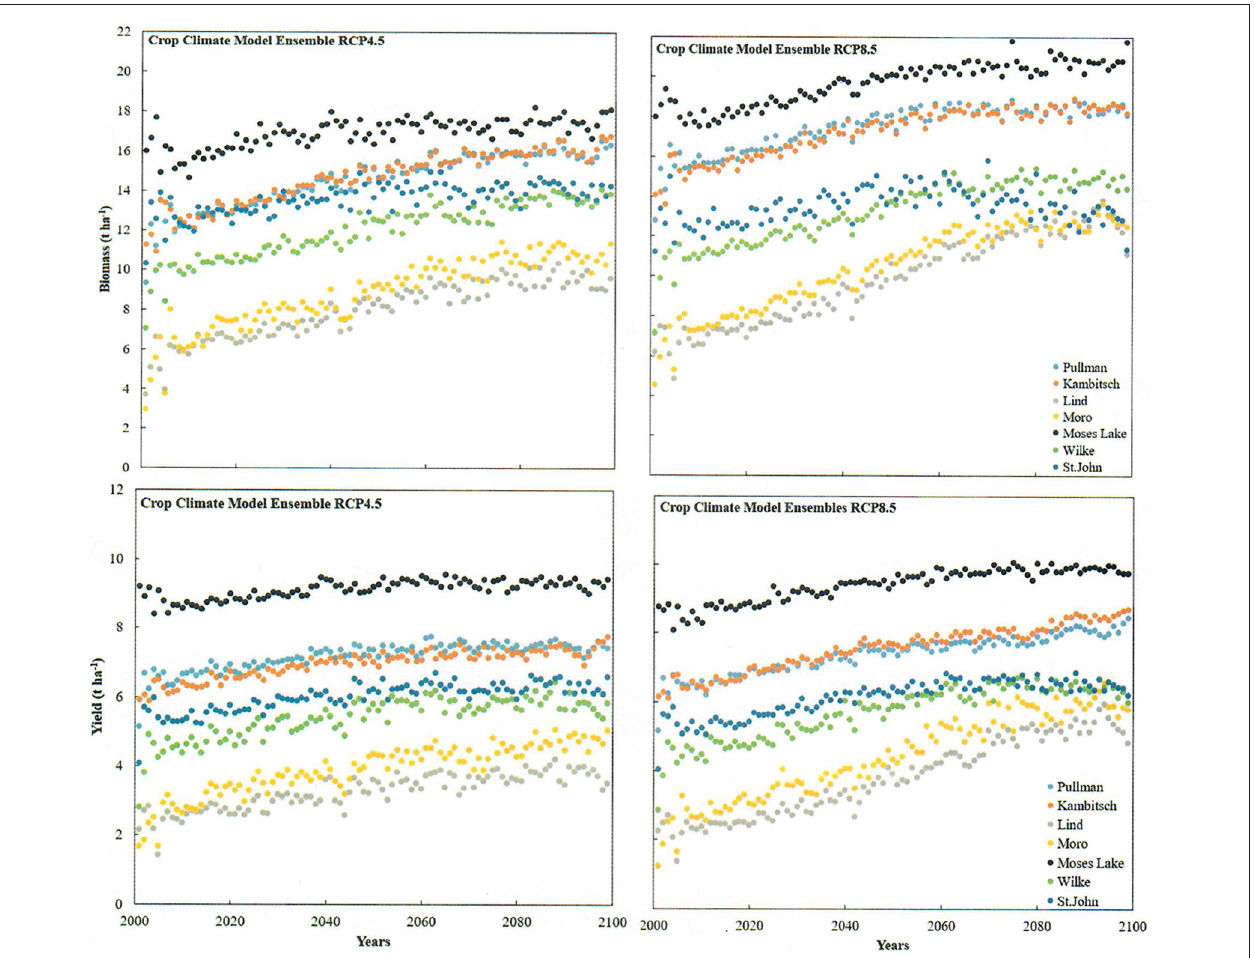
FIGURE 4 | Winter wheat biomass (t ha − 1 ) and grain yield (t ha − 1 ) trends by the crop climate model ensemble approach using two representative concentration pathways (RCP4.5 and 8.5) at seven diverse agroecological sites in the Inland Pacific Northwest.